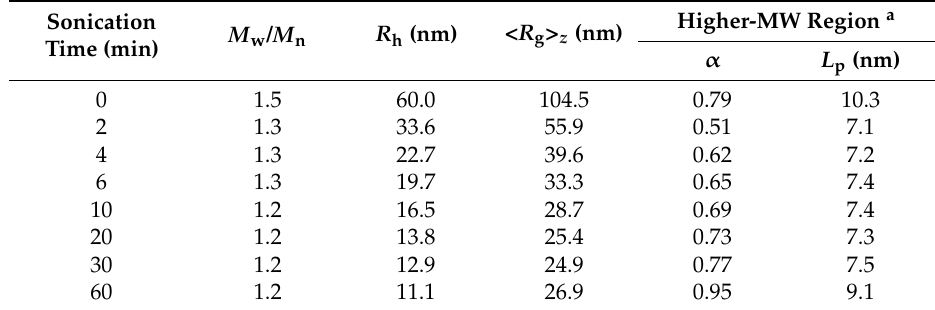
Figure 1. High-performance size-exclusion chromatography (HPSEC) chromatograms of konjac glucomannan (KGM) fractions (US-0, US-4, US-10, and US-60: ultrasonication (US) treatment for 0, 4, 10, and 60 min at a fixed amplitude of 60%). Table 1. Effects of ultrasonication (US) on molecular properties and conformation of konjac glucomannan (KGM) fractions derived from analysis with high-performance size-exclusion chromatography (HPSEC) equipped with multi-angle laser light scattering (MALLS) detector, viscometer (Vis), and refractive index RI detector. MW—molecular weight.